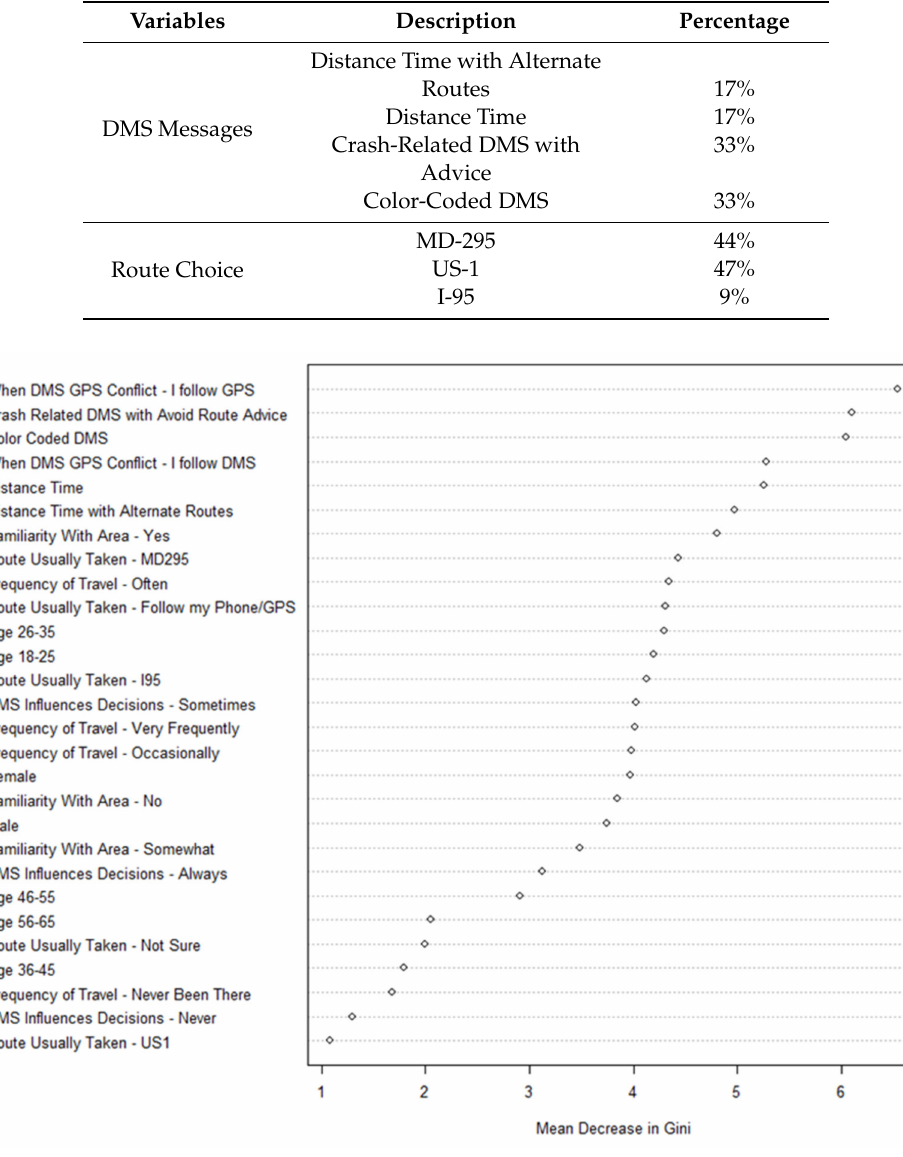
Figure 9. Plot of variable importance for route choice by MDG